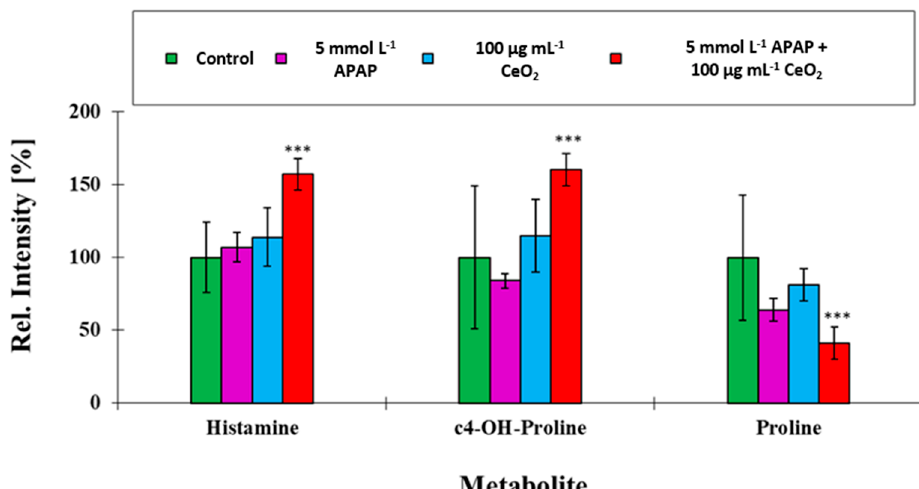
Figure 11. Comparison of ion yields for characteristic biomarker metabolites addressed in the tar- geted metabolomics experiment of cells co-exposed to APAP (5 mmol L − 1 ) and CeO 2 NPs (100 µg mL − 1 ). These metabolites were used to separate the four treatment groups. The mean of the control group of unexposed HuH-7 cells was taken as 100% in all cases. ***: p ≤ 0.05.